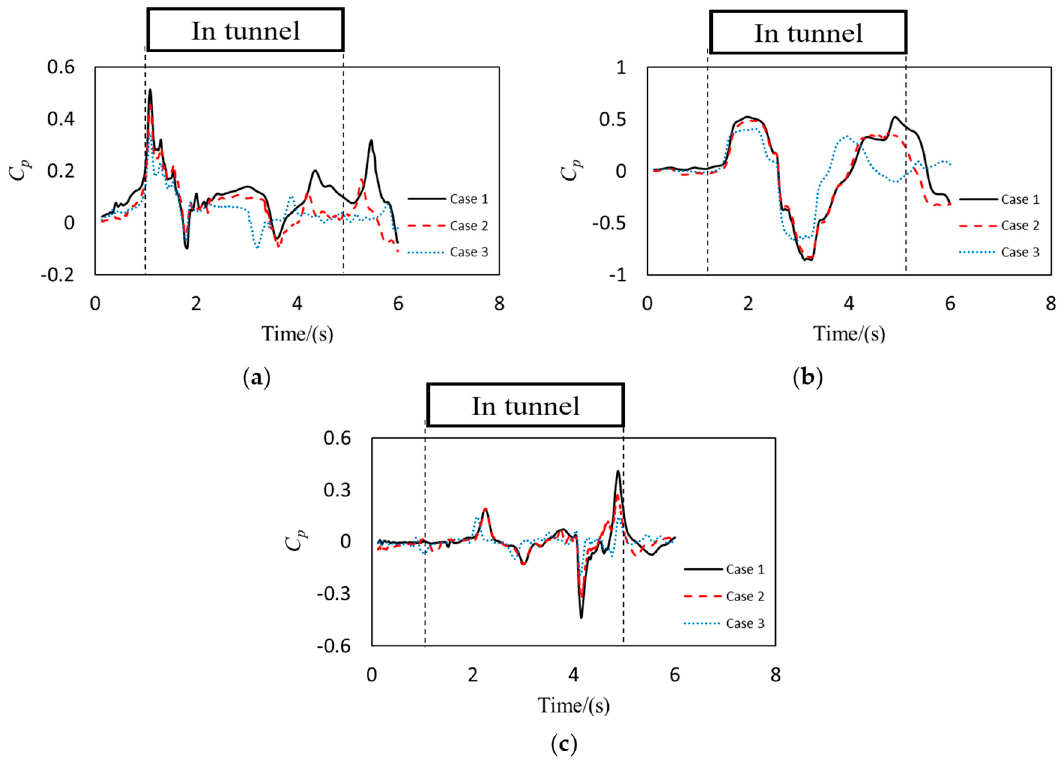
Figure 14. (cid:1829) (cid:3043) history at monitoring points on the cross section of tunnel wall at: ( a ) S 2 ; ( b ) S 10 ; ( c ) S 18 .